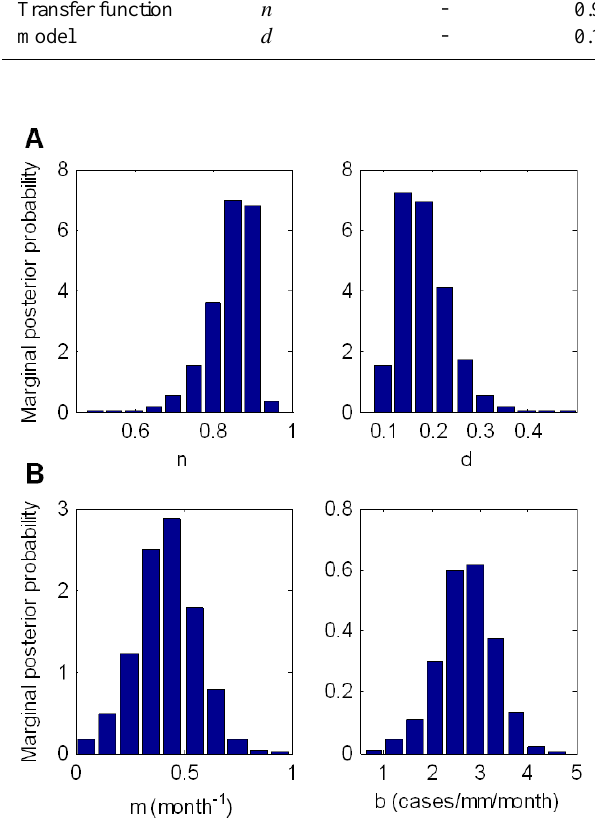
Fig. 5. Posterior parameter distributions for (A) ecohydrological and (B) transfer function models at Mpumalanga. 95% confidence bands for the parameters are given in Table